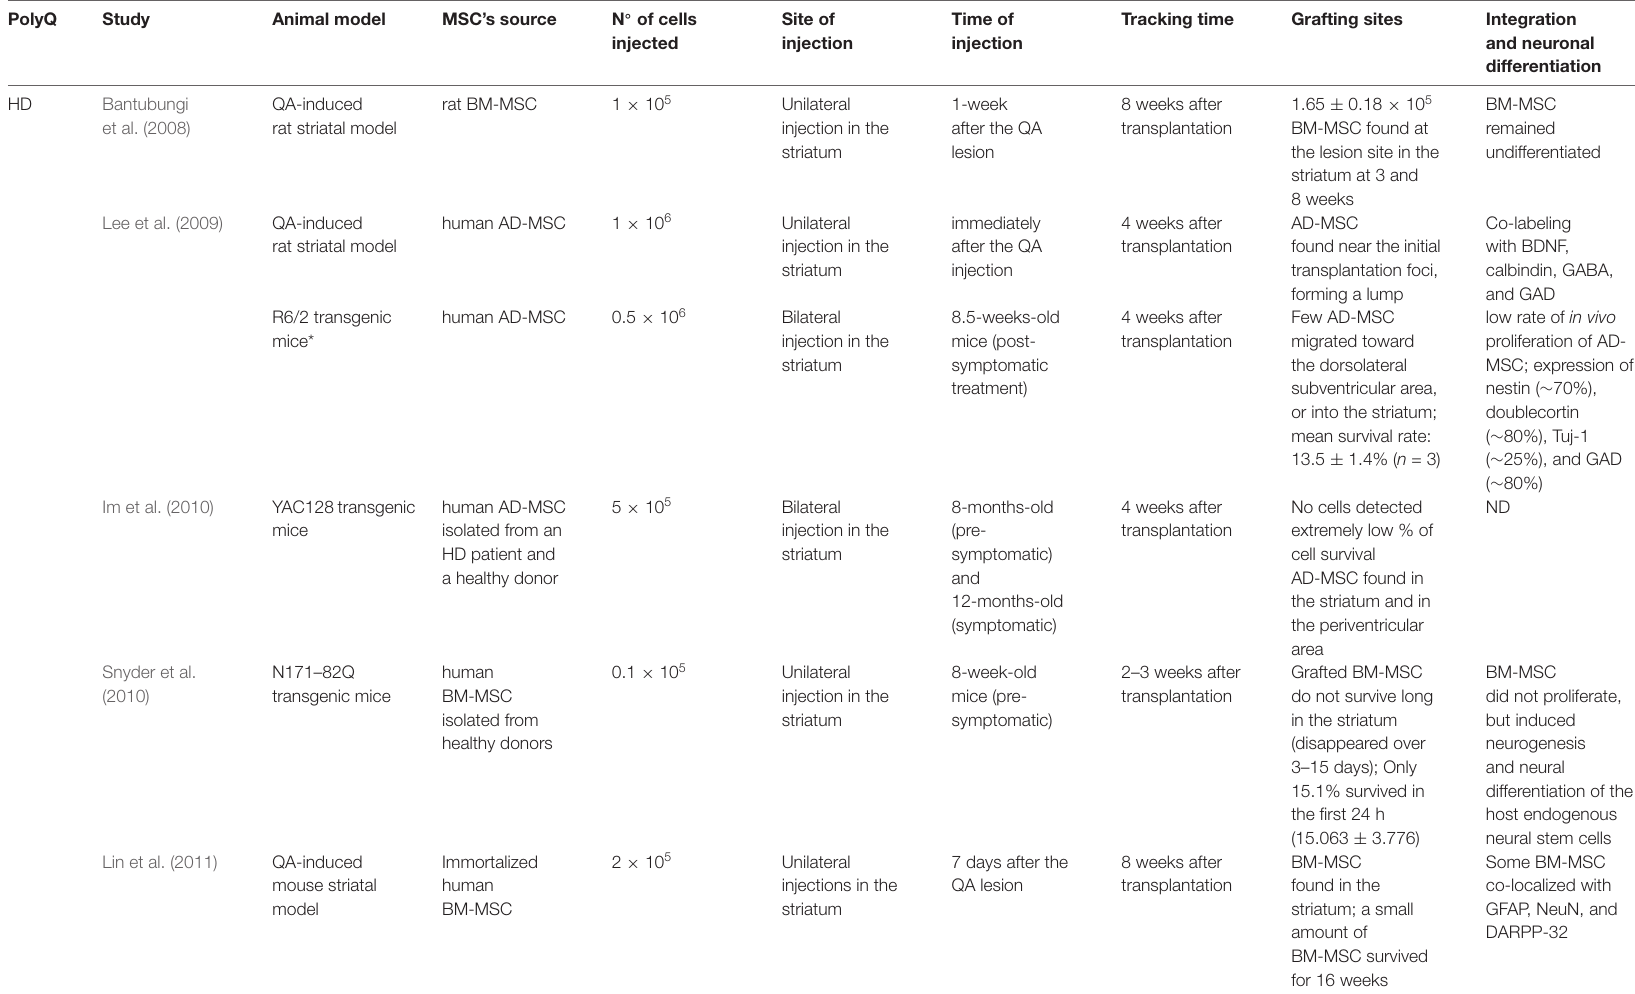
TABLE 1 | Sum up of the survival, grafting, and integration of mesenchymal stromal cells (MSC) in pre-clinical studies in animal models of polyglutamine (polyQ) disorders.